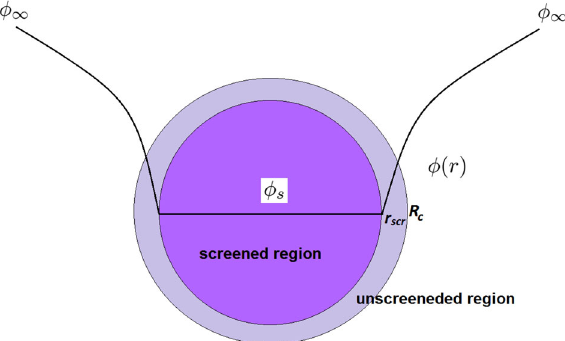
Fig. 15 Thin shell profile of the scalar field for the chameleon screening mechanism. Only the mass of the thin shell contributes to the fifth force outside the shell while the force is suppressed inside the shell. See text and Khoury and Weltman (2004a) and Koyama (2016) for discussion